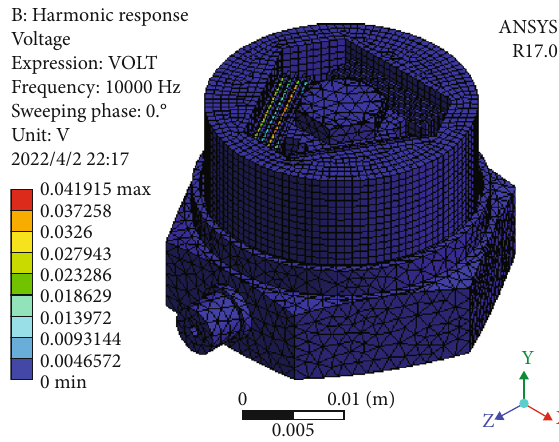
Figure 8: Voltage distribution diagram of the designed